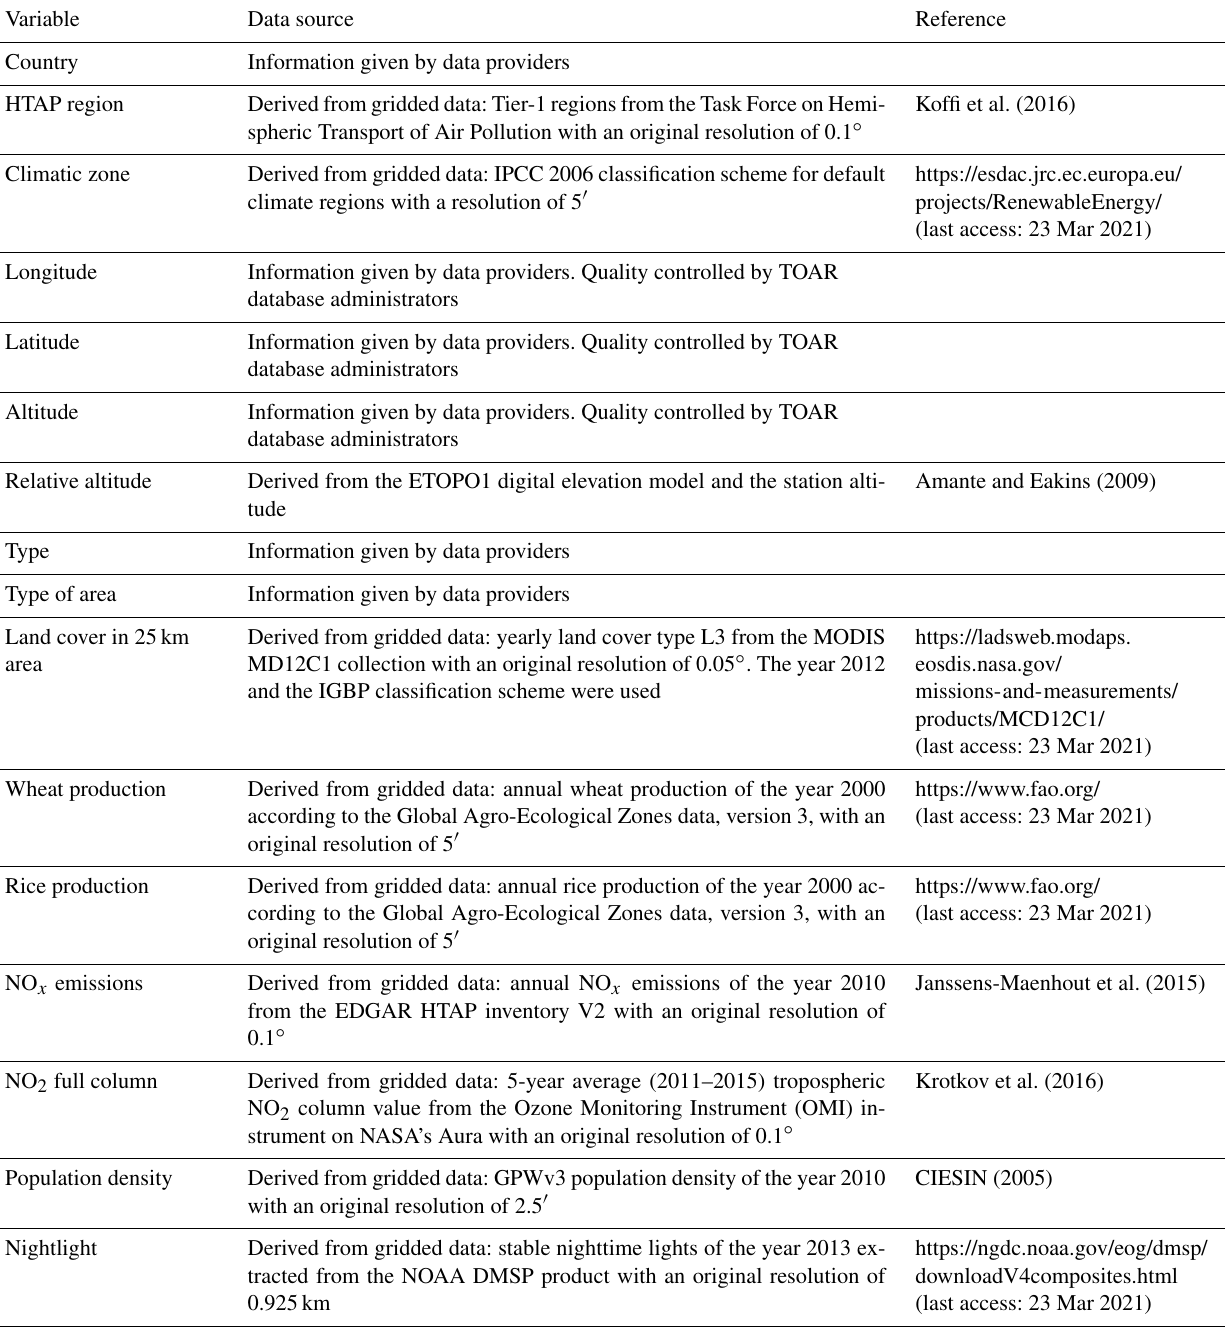
Table A1. Technical details on the station metadata of the AQ-Bench dataset, updated from Schultz et al. (2017). Please note that in order to keep this table uncluttered, we have summarized all types of land cover in a 25km area, all population density and all nightlight variables in one row